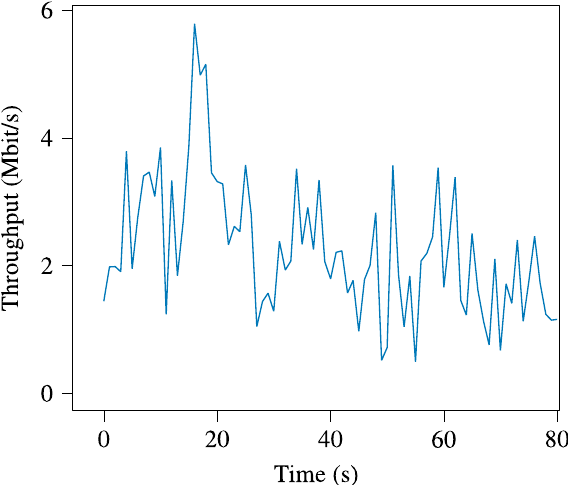
Figure 6. Service channel throughput during H9 and H10’s attack of H3 and H4.